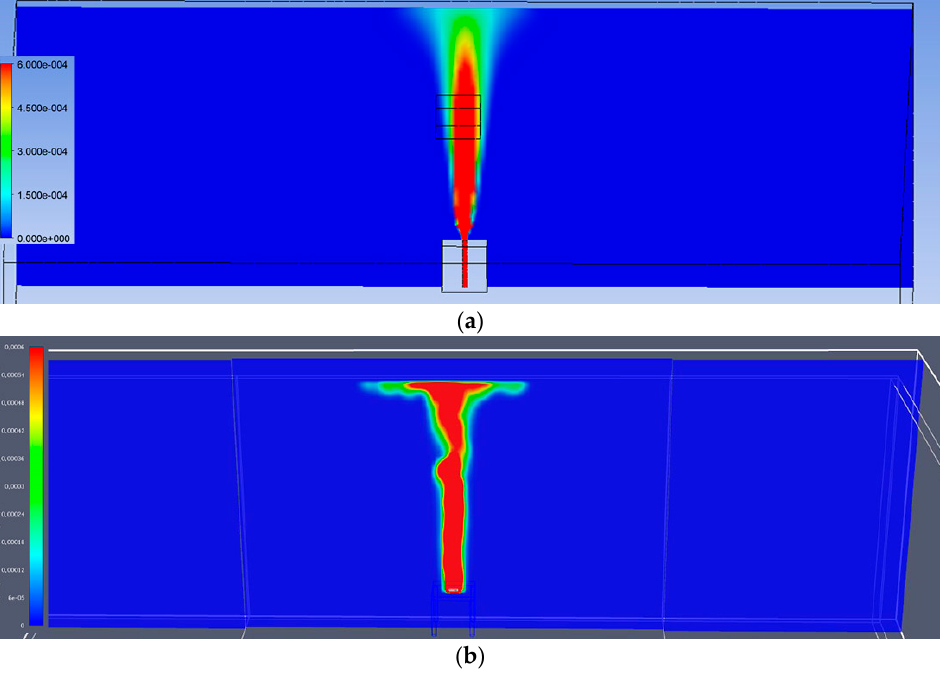
Figure 16. Comparison of hydrogen dispersion for 1.5% concentration of LEL for time 50 s: ( a ) propane release calculated with Ansys software; ( b ) propane release calculated with FDS software. Results after 100 s indicated that hydrogen occurred below the ceiling in the area equal to approximately 10 m for both FDS and Ansys software (Figure 17).